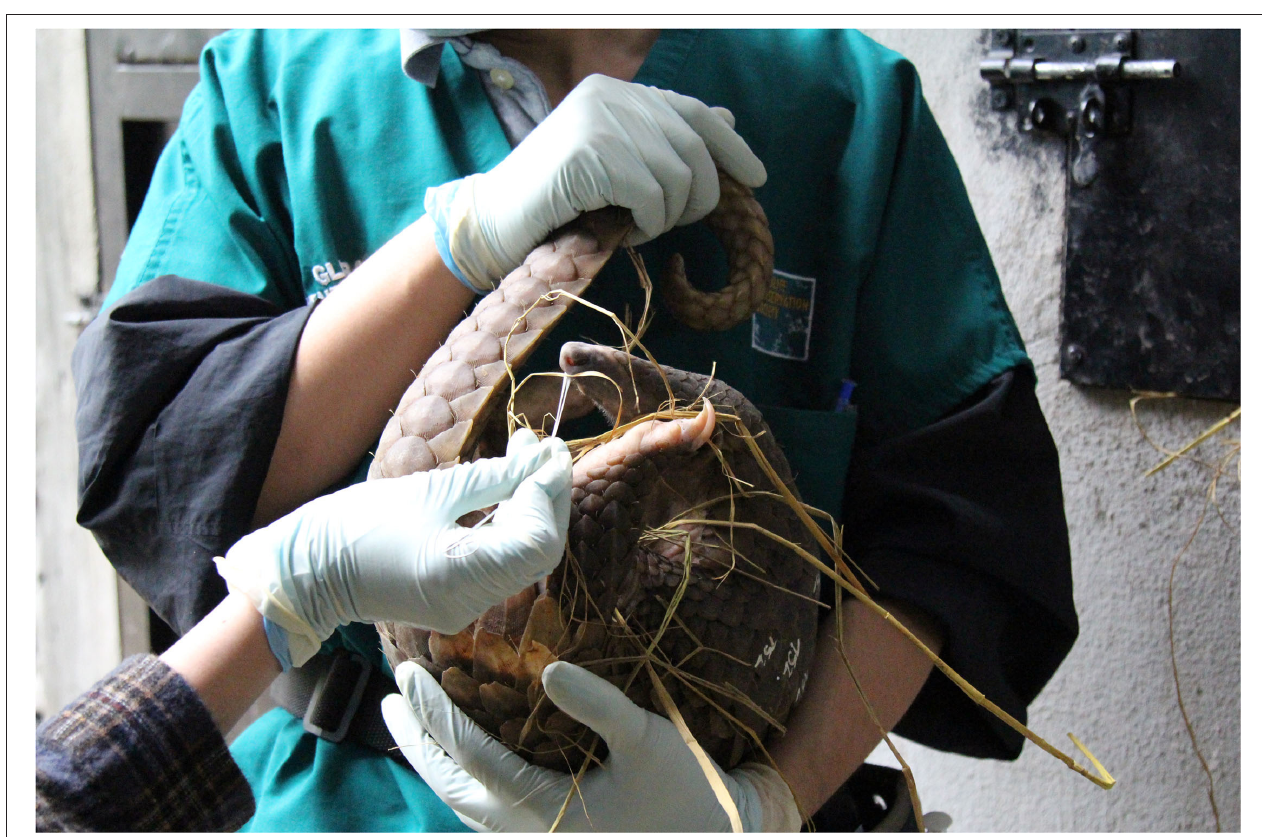
FIGURE 1 | A young Sunda pangolin restrained manually for sample collection. It is possible to restrain small pangolins manually for sample collection if the procedure can be completed quickly in a quiet, low light area to limit stress on the pangolin. Photo courtesy of Wildlife Conservation Society, Viet